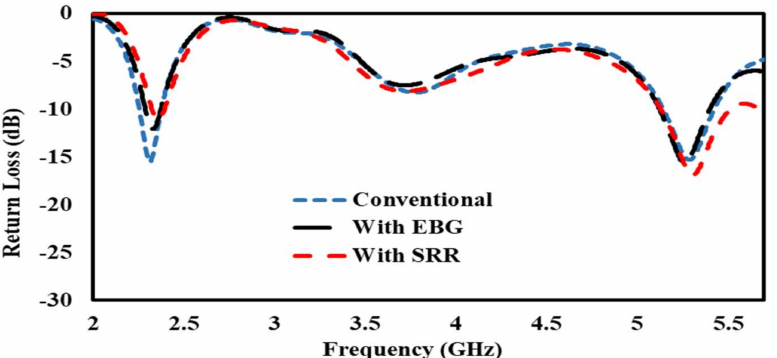
Figure 18. Return loss comparison of conventional antenna, antenna on EBG, and SRR/HIS bent on human